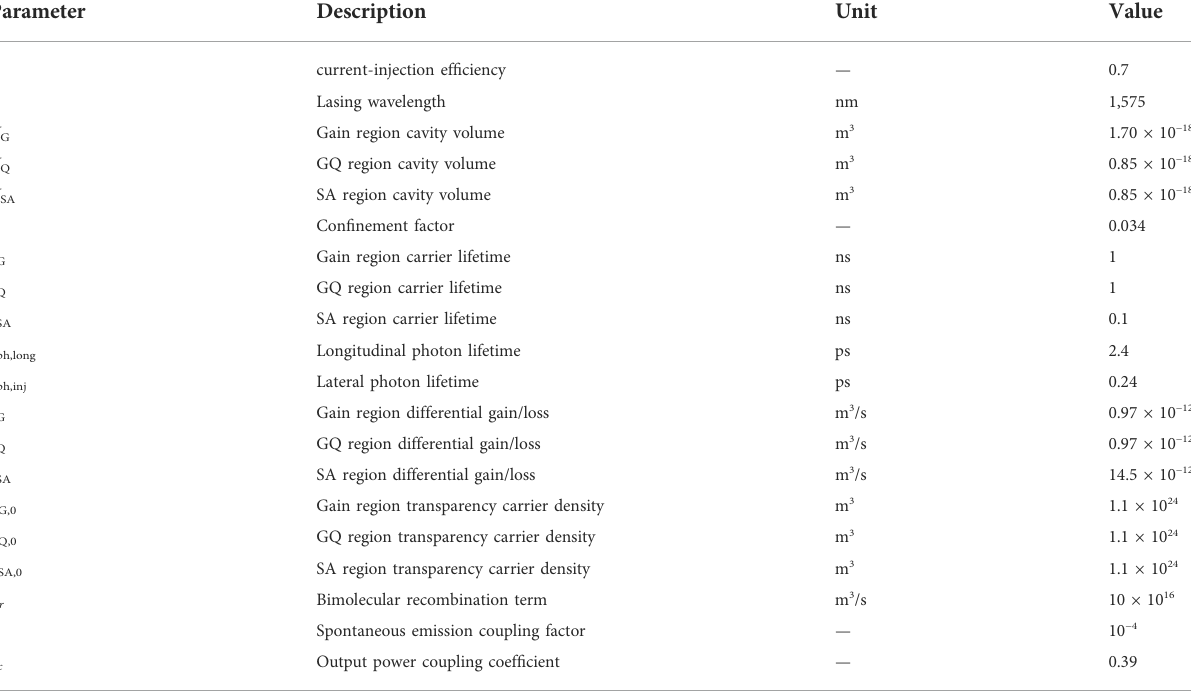
TABLE 1 Parameters used in the DFB-SA laser neuron model [17]. Parameter